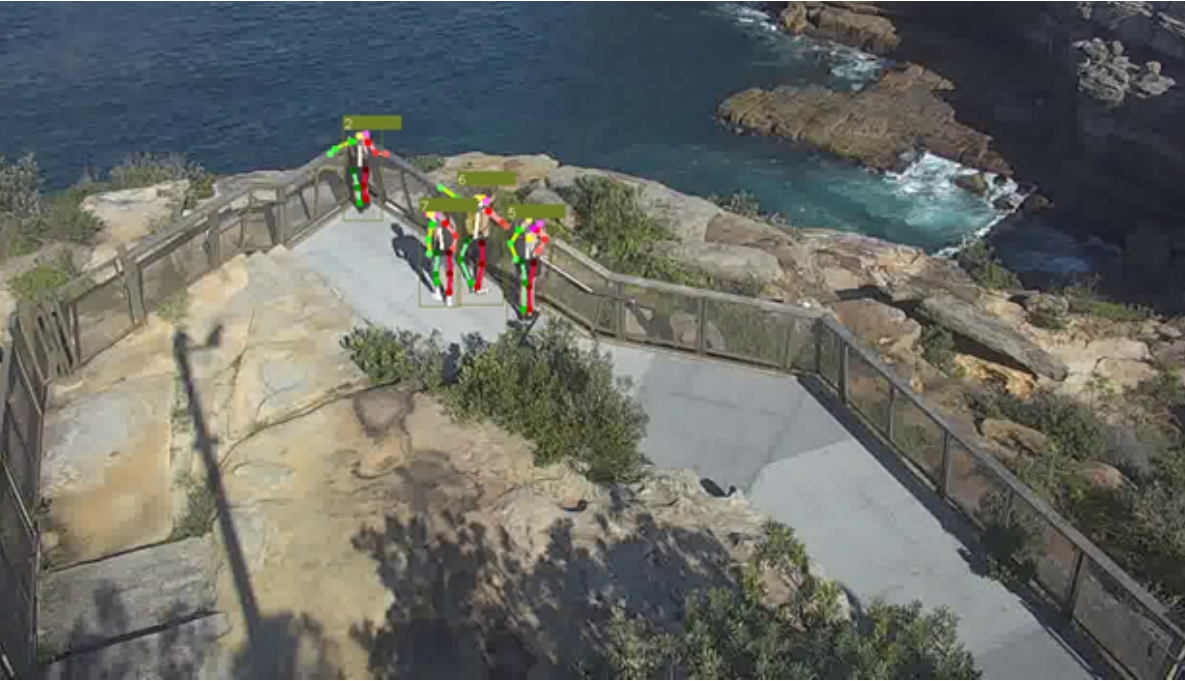
Figure 7. Pose Estimation Module Output. The joint locations and limbs are identified by a pose estimation model. For better visibility, the other visualizations for grouping and trajectory analysis have been